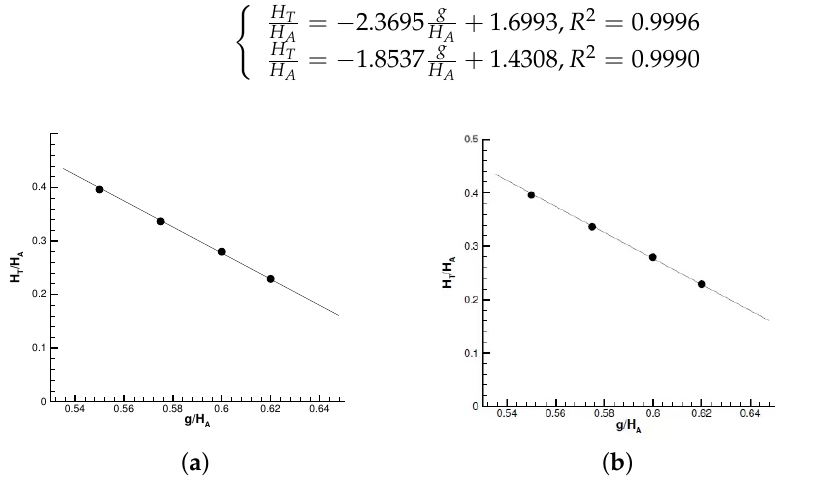
Figure 5. Numerical results for normalized Mach stem heights as a function of the normalized wedge trailing edge height: ( a ) H T θ w = 25 ◦